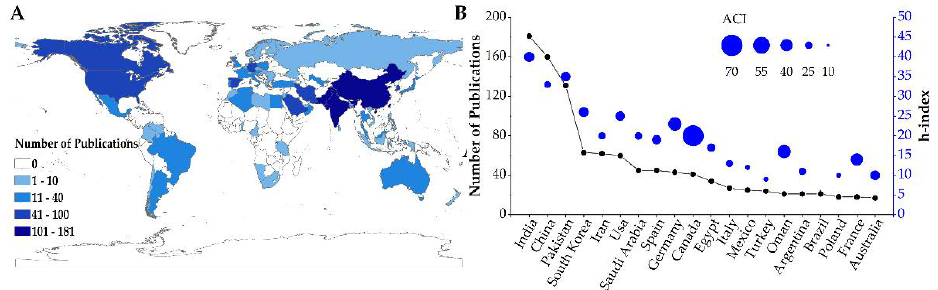
Figure 3. ( A ): a world map depicting the contribution of each country based on publication counts; ( B ): NP of the top 20 most productive lands and their corresponding h –index, ACI.